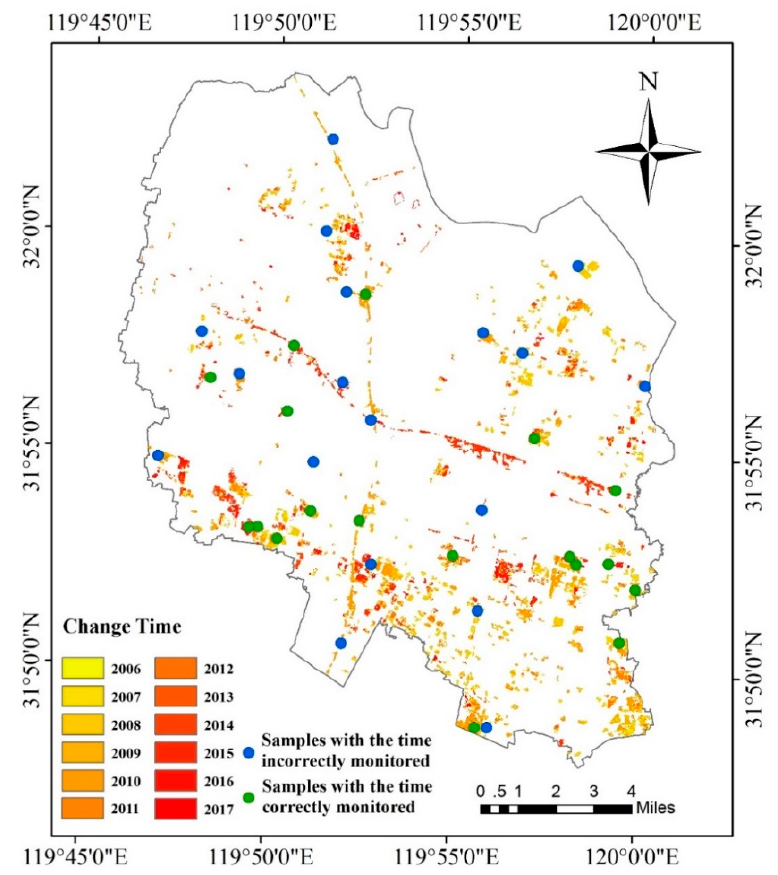
Figure 12. Spatial distribution of samples in Figure 13.